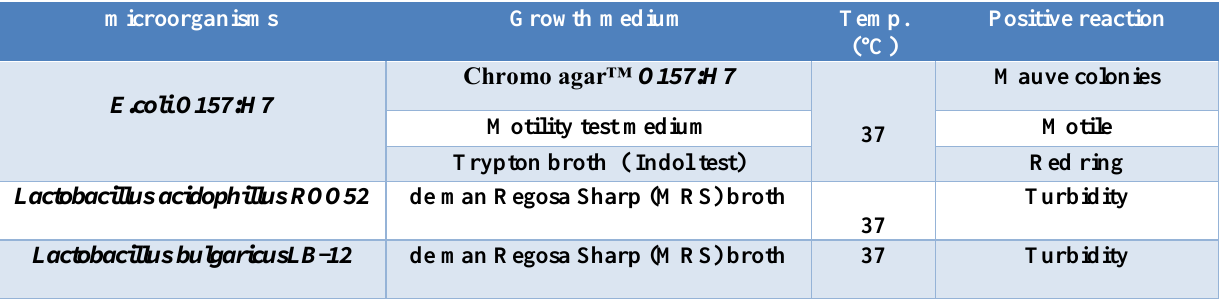
Table, 2: Serological and biochemical characteristics of E. coli O157:H7 Potassium cyanide (KCN)